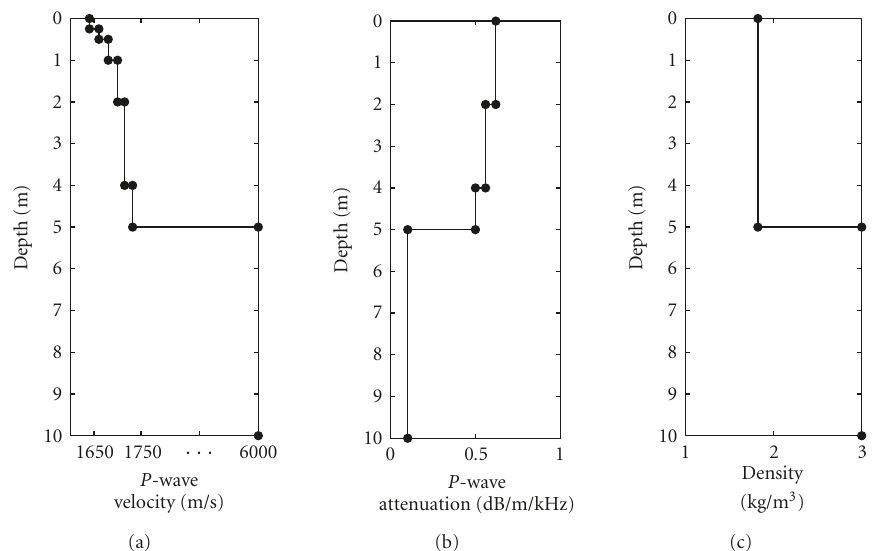
Figure 2: Vertical structure of the seabed: P -wave velocity (a), P -wave attenuation (b) and density (c).